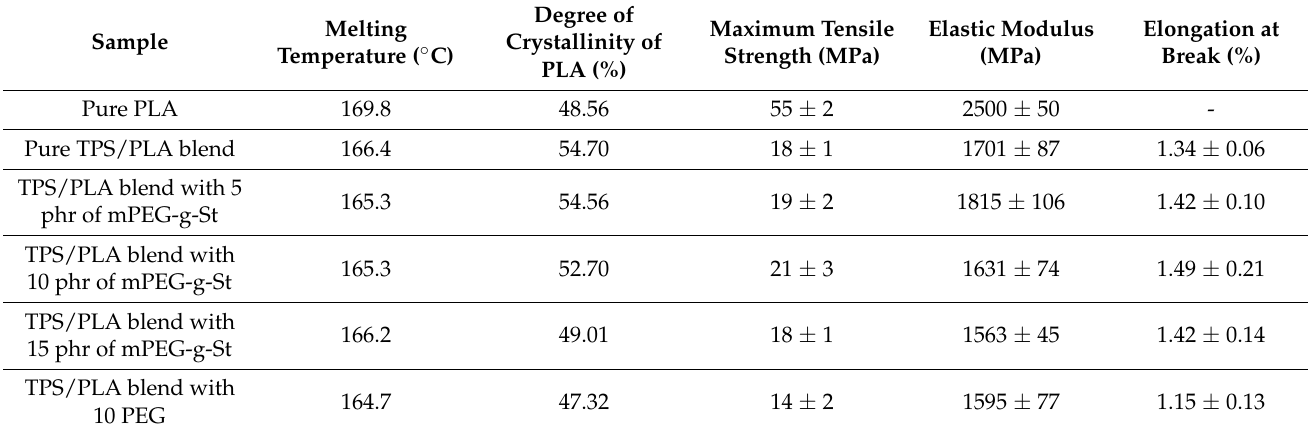
Table 5. Thermo-mechanical properties and the variation of the degree of crystallinity of the blends